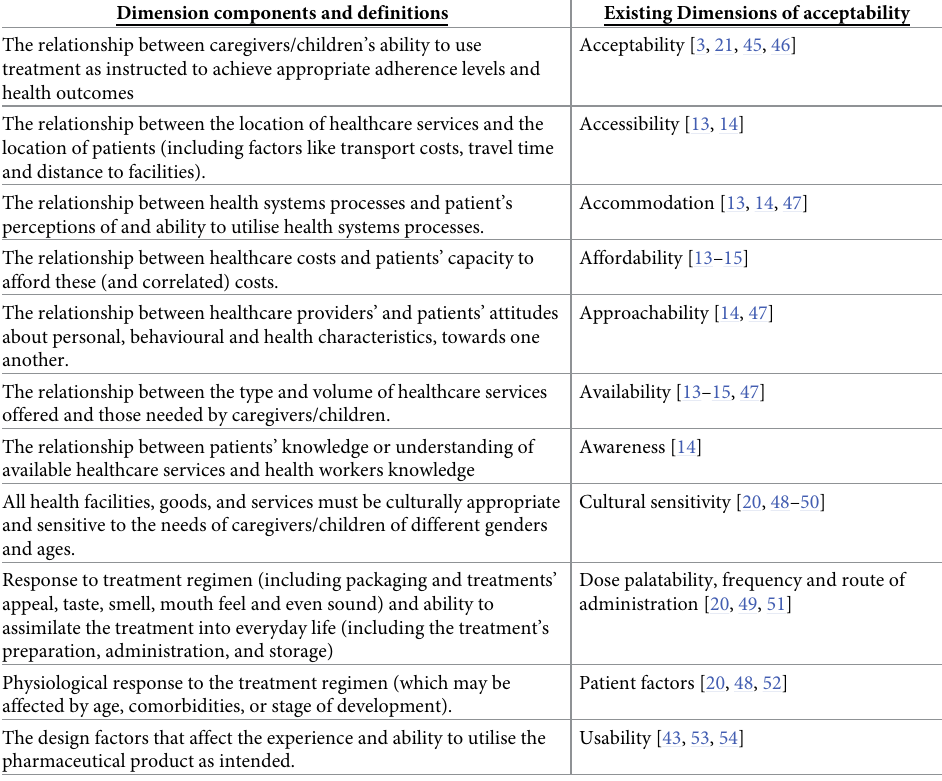
Dimension components and